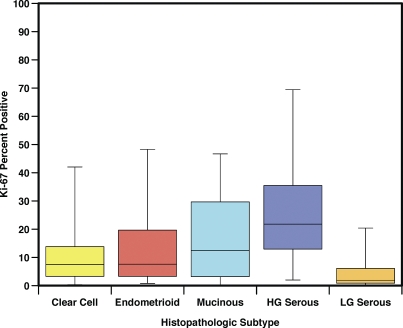
Distribution of Ki-67 Labelling Index across Subtypes